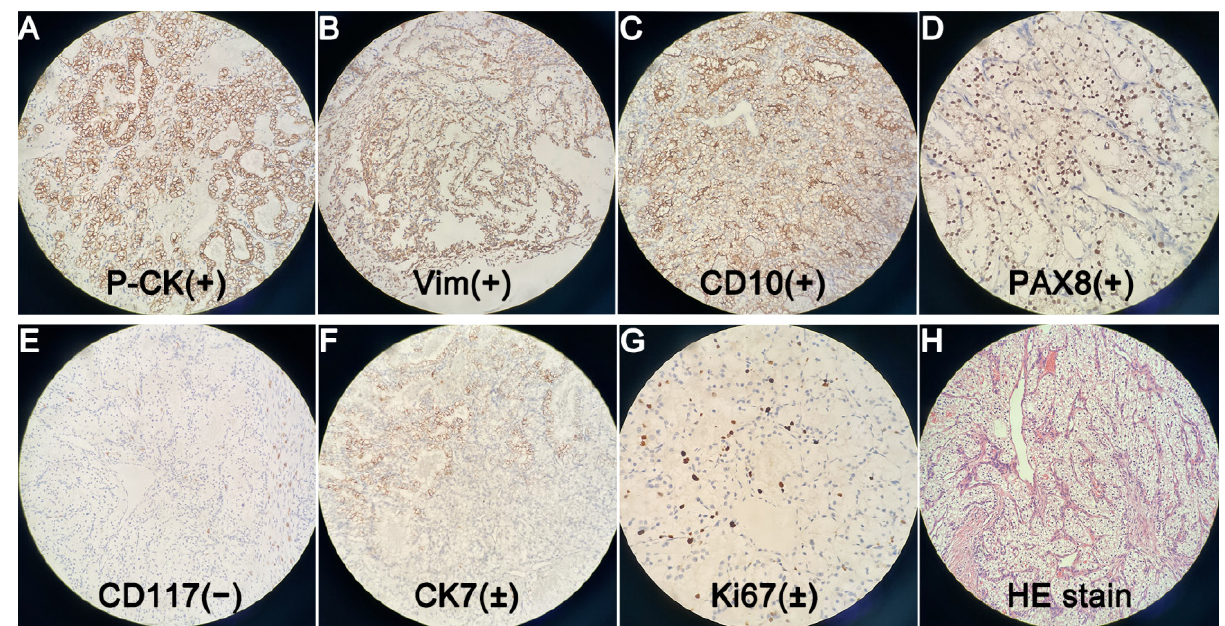
Figure 5. ( × 200). Postoperative pathology showed metastatic ccRCC, with Fuhrman nuclear grade I. Immunohistochemical staining suggested Pan Cytokeratin (P ‐ CK) (+) ( A ), Vimentin (Vim) (+) ( B ), Cluster of Differentiation 10 (CD10) (+) ( C ), Paired Box Gene 8 (PAX8) (+) ( D ), Cluster of Differentiation 117 (CD117) ( − ) ( E ), Cytokeratin 7 (CK7) (±) ( F ), Cell Proliferation Antigen Ki67 (Ki67) (±) ( G ). Other markers such as Renal Cell Carcinoma Marker (RCC ‐ Ma), Transcription Factor Binding To IGHM Enhancer 3 (TFE3), Carbohydrate Antigen 199 (CA199) were all negative, but they were not